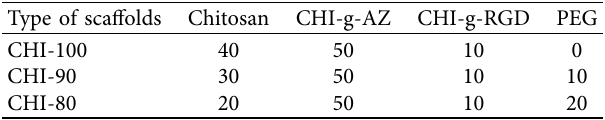
Table 1: Te weight percentages of the compositions in the